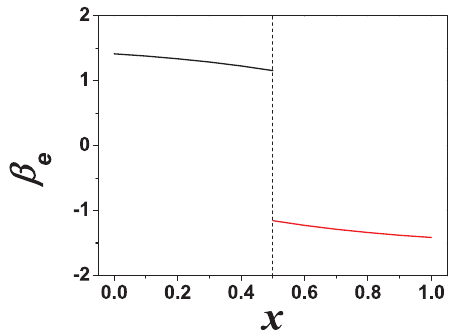
Figure 1. The classical order parameter β e , which is defined as the optimal value of β , is shown as function of the control parameter x .